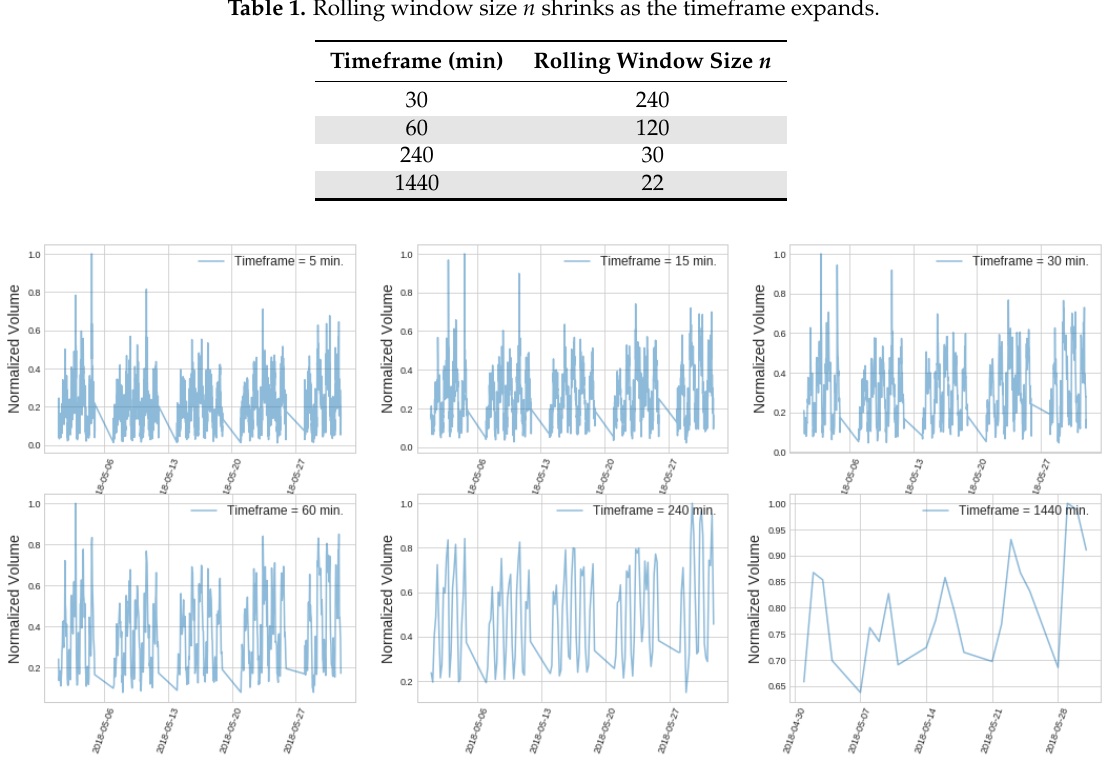
Figure 4. Daily periodicity of volume data for EURUSD pair in May